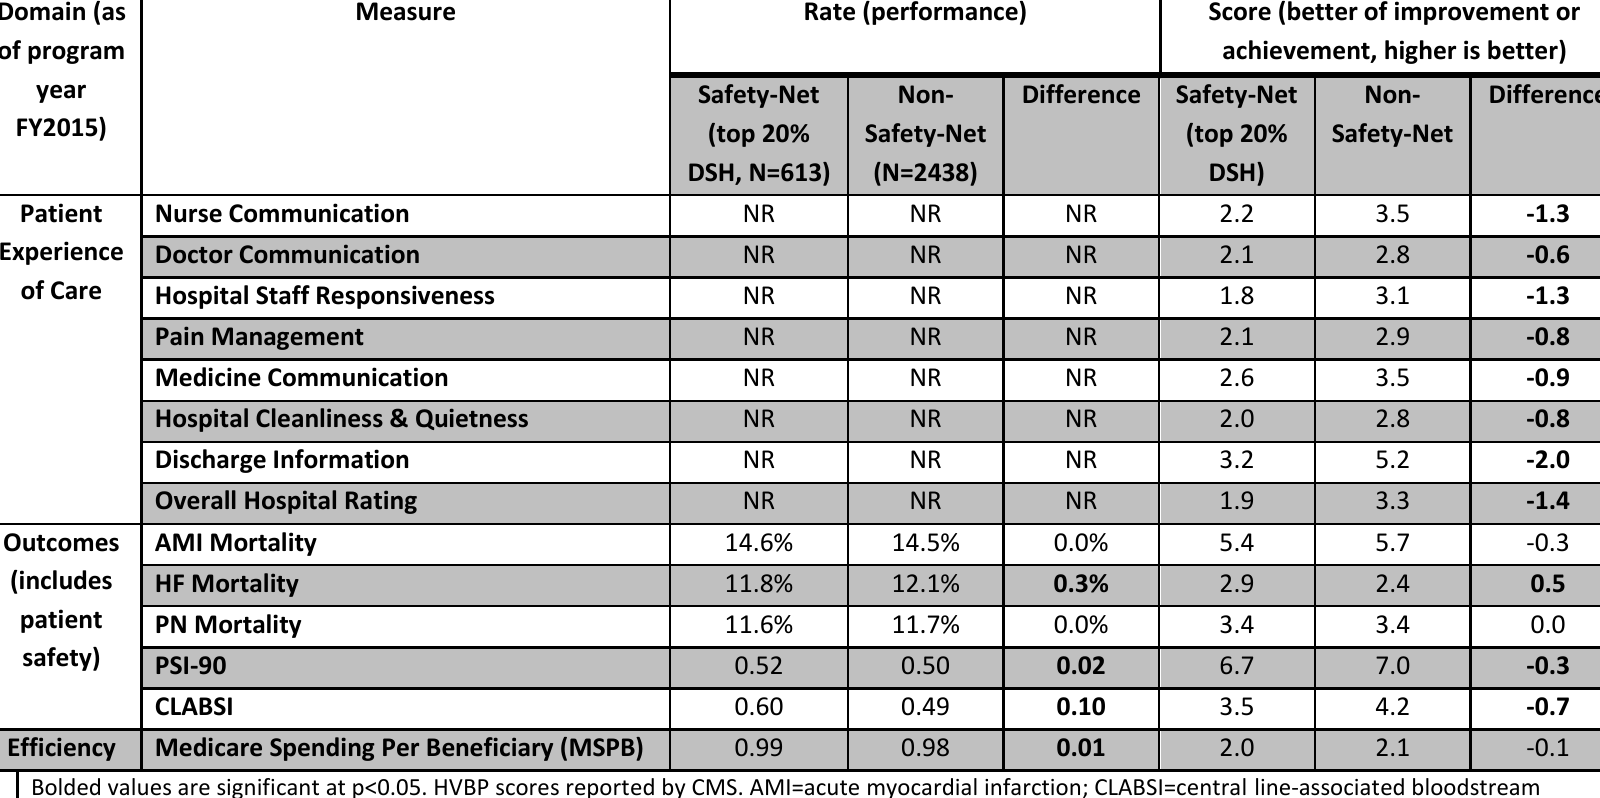
Table 7.8: FY2015 Measure Rates and Scores, by Hospital Safety-Net (top 20% DSH) Status Domain (as of